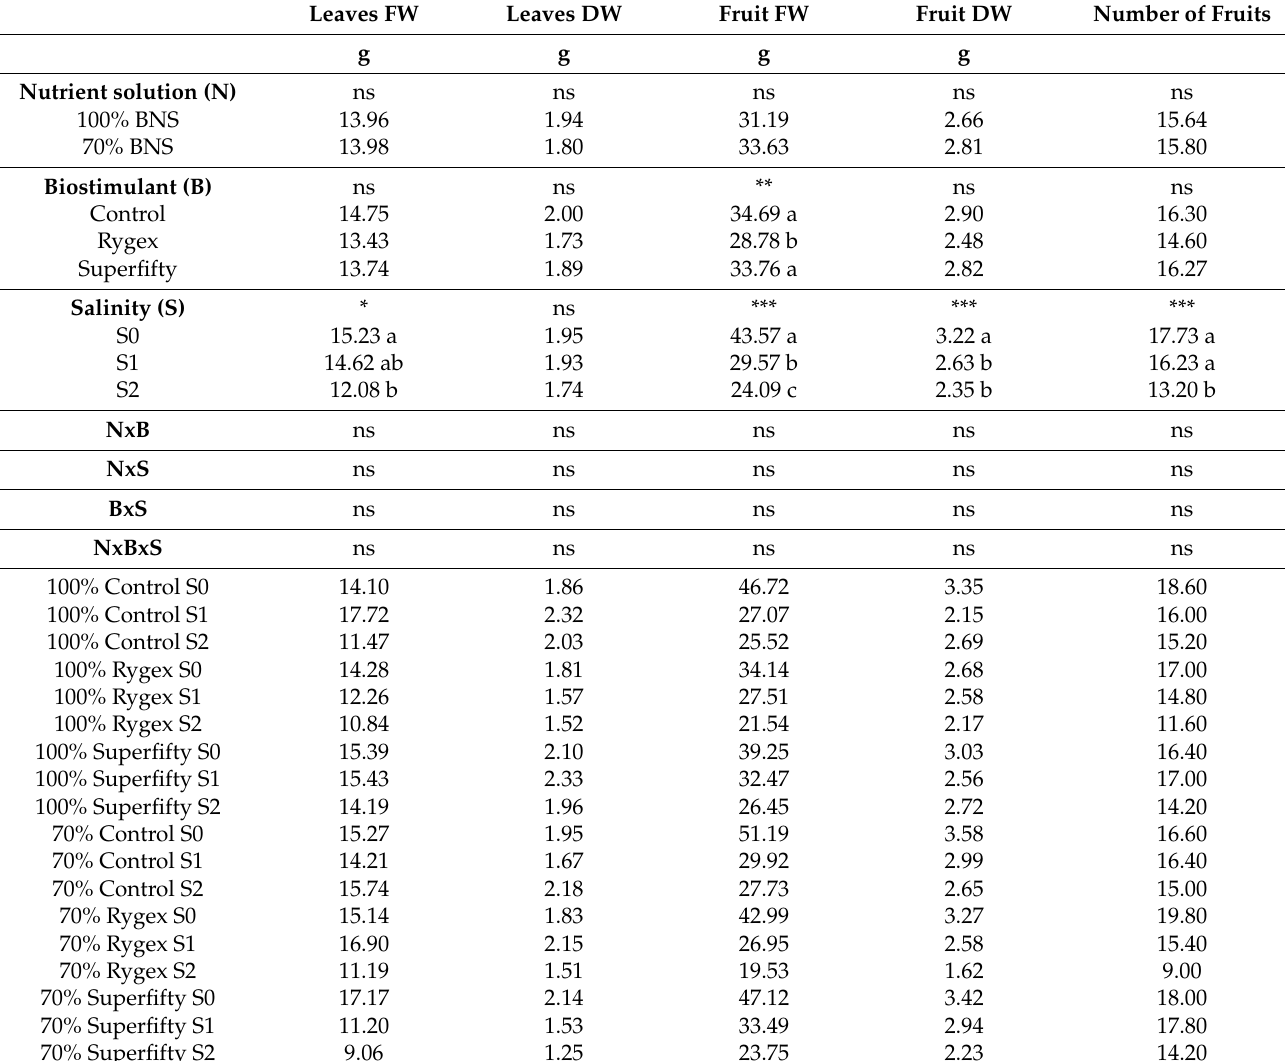
Table 1. Significance of the main factors (nutrient solution, biostimulant and salinity) and their interactions on leaves fresh and dry weight, shoot fresh weight, plant height, fruit fresh weight and dry weight and number of fruits. MicroTom plants were harvested at 90 days after sowing (DAS) after being fertigated since 35 DAS with a 100% or 70% basic nutrient solution (BNS), in combination with two different commercial Ascophyllum nodosum extracts, Rygex at 2.5 mL L − 1 and Superfifty (SF) at 2.0 mL L − 1 and three salinity levels of 0 (S0), 42.5 (S1), and 85 (S2) mM NaCl. Control was without biostimulant. Leaves FW Leaves DW Fruit FW Fruit DW Number of